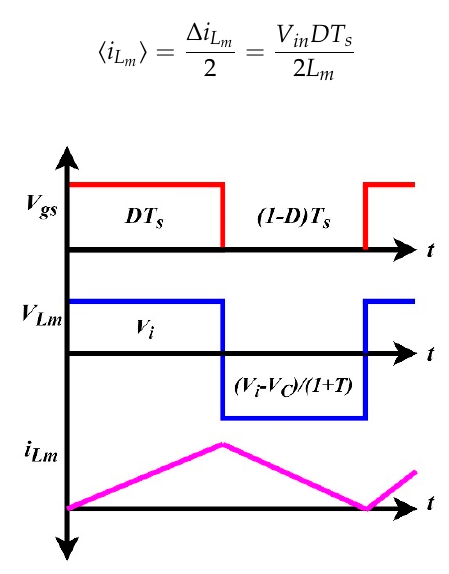
Figure 7. Voltage and current waveform during BCM.